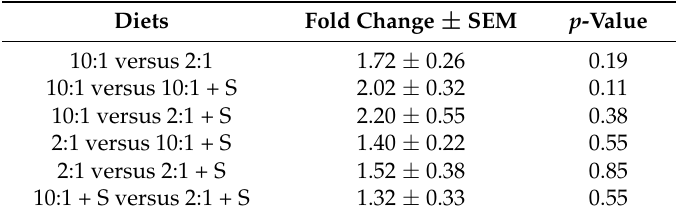
Table 3. Expression of PPAR γ mRNA in the subcutaneous